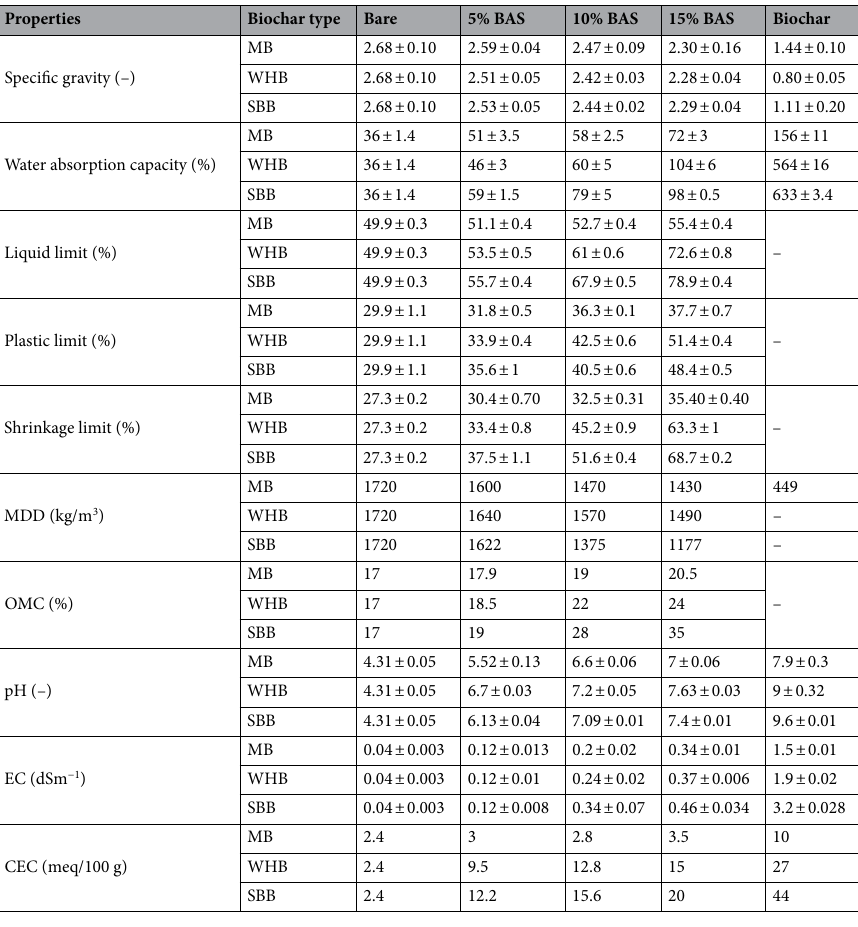
Table 2. Physicochemical properties of the BAS. Value in table represents the average value ± standard deviation. CEC cation exchange capacity, EC electric